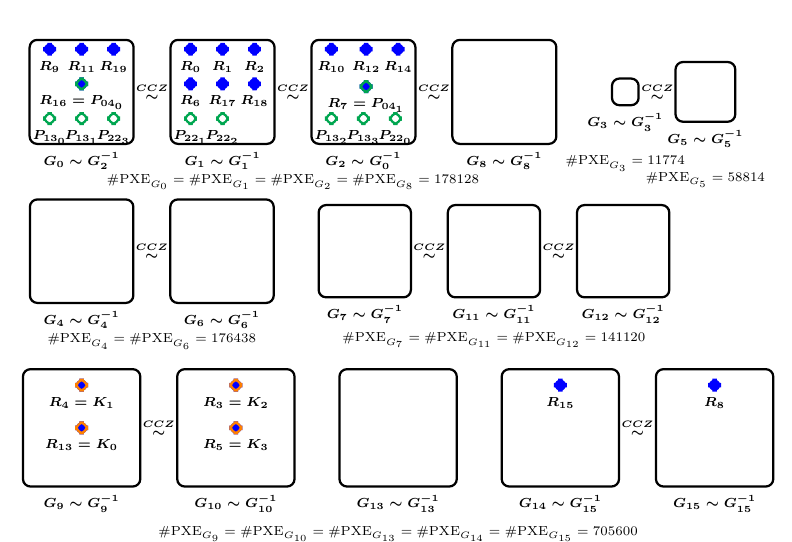
Figure 1: Relations between known equivalent classes of 4-bit S-boxes. In this figure, G 0 to G 15 (in black frame) are the 16 non-AE optimal 4-bit S-boxes in [LP07] (see Table 11); R 0 to R 19 (in blue) are the 20 non-PXE Serpent-type S-boxes in [LP07] (see Table 12); K 0 to K 3 (in orange frame) are the 4 non-PXE Golden S-boxes in [Saa11] (see Table 13); P ij (in green frame) are the 10 non-PXE Platinum S-boxes in [ZBRL15] (see Table k